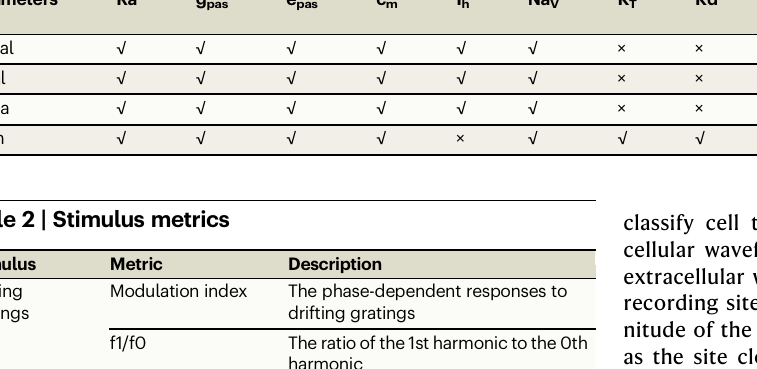
Table 1 | Inclusion of each parameter in the morphology sections Parameters